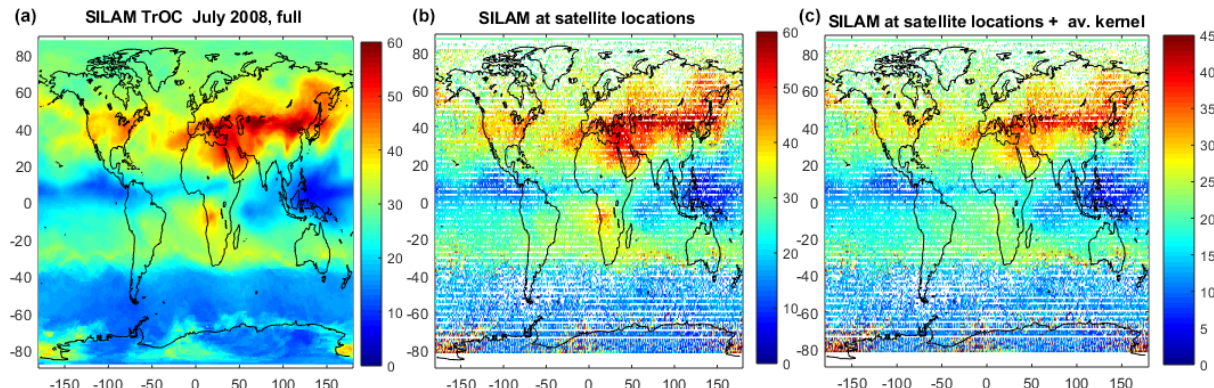
Figure 4. Estimates of full tropospheric ozone column (from the ground to the tropopause) using the application of the residual method to SILAM ozone profiles for the monthly average of July 2008. (a) TrOC is computed using the full SILAM ozone field, (b) SILAM data are subsampled at locations of nadir and limb satellite instruments, and (c) averaging kernel is taken into account in computing total ozone column at OMI locations. The sampling pattern corresponds to the combined dataset of GOMOS, MIPAS, SCIAMACHY, MLS, and OSIRIS